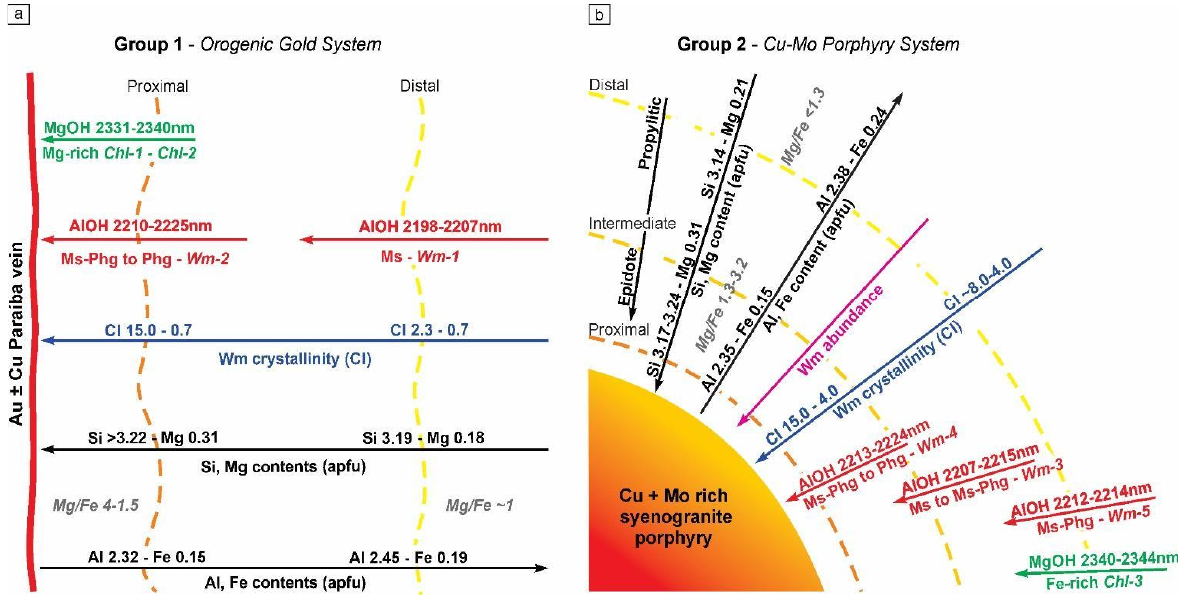
Figure 14. Hypothetical representation of footprints and vectors for the mineral exploration of orogenic gold and Cu-Mo porphyry systems in the Paraíba deposit. ( a ) Orogenic gold system: hydrothermal system related to the NE-trending shear zone. Main vectoring minerals and their compositional and crystallinity variations according to proximal or distal zones. ( b ) Cu-Mo porphyry system: magmatic-hydrothermal. Main vectoring minerals and their compositional and crystallinity variations according to proximal or distal zones. Chl: chlorite; Ms: muscovite; Ms-Phg: white mica with intermediate composition muscovite-phengite; Wm: white mica. The terms Wm–1, –2, –3,